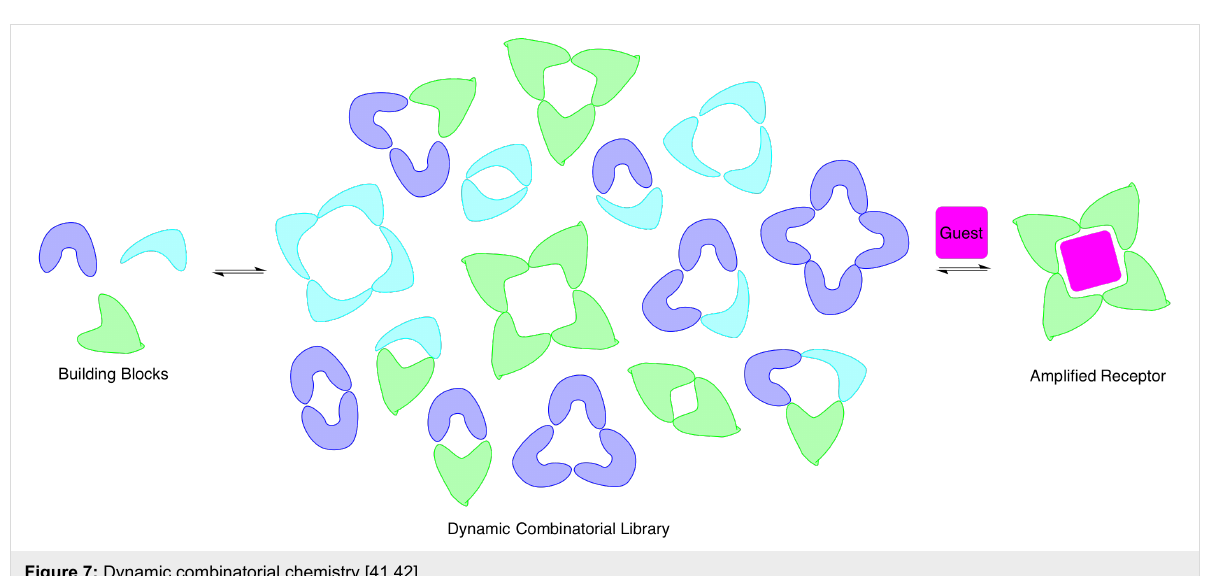
Figure 7: Dynamic combinatorial chemistry